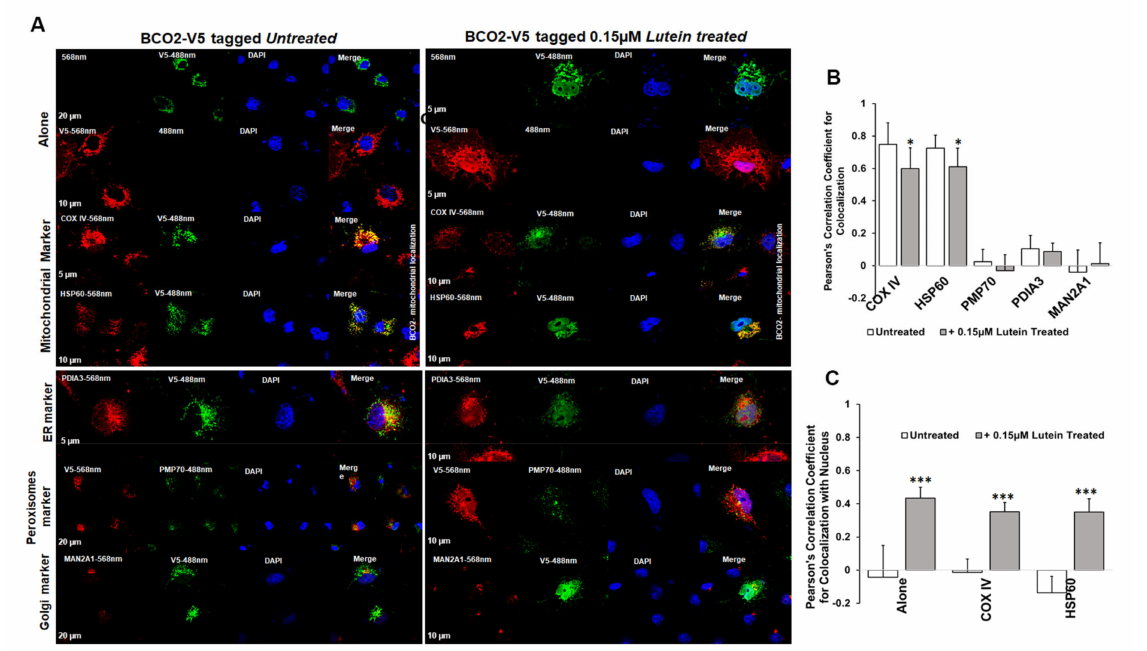
Figure 3. Characterization of subcellular localization of mBCO2 treated with lutein. ( A ) COS7 cells expressing mBCO2 protein treated with 0.15 µ M lutein for 5 h were immunoassayed using antibodies against V5 tag and different organelle marker proteins as indicated in the Materials and Methods section. Pearson’s correlation coefficient for colocalization of V5-tagged mBCO2 protein with different organellar marker proteins ( B ) and with nucleus ( C ); * p ≤ 0.05; *** p ≤ 0.0005.